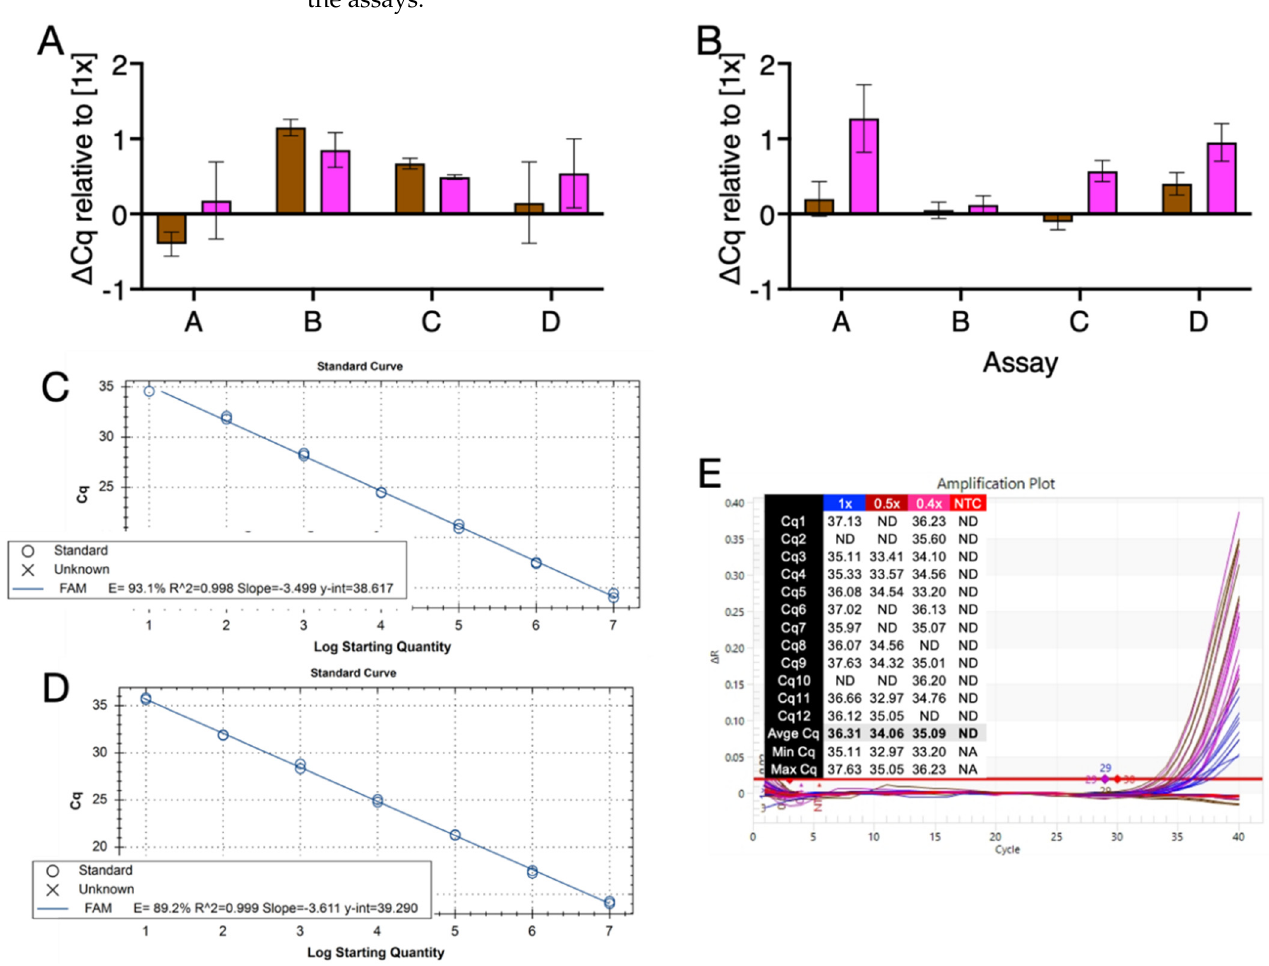
Figure 6. Assessment of Promega master mix at various final concentrations. ( A ). ∆ Cq values of 0.5 × (brown) and 0.4 × (pink) compared with 1 × final concentration recorded with the four assays. ( B ). Repeat reaction with freshly prepared primers and probes. ∆ Cq values of 0.5 × (brown) and 0.4 × (pink) compared with 1 × concentration recorded with the four assays ( C ). Standard curve and PCR efficiency of assay D amplified by 0.5 × concentration master mix. ( D ). Standard curve and PCR efficiency of assay D amplified by 0.4 × concentration master mix. ( E ). Limits of detection for assay A at 1× (blue), 0.5 (brown) or 0.4× (pink) master mix concentration.